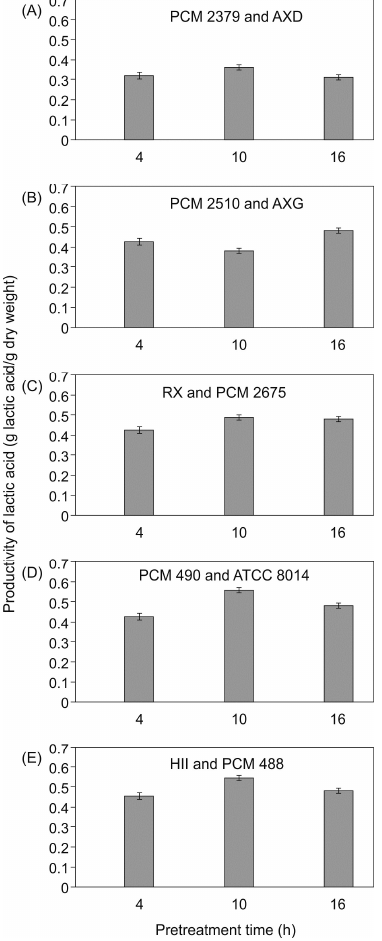
Figure 4. Productivity of lactic acid for ( A ) Lactococcuss lactis PCM 2379 and Lactobacillus plantarum AXD, ( B ) Lactobacillus acidophilus PCM 2510 and Lactobacillus plantarum AXG, ( C ) Lactobacillus plantarum R and Lactobacillus plantarum PCM 2675, ( D ) Lactobacillus delbrueckii PCM 490 and Lactobacillus plantarum ATCC 8014, and ( E ) Lactobacillus plantarum HII and Lactobacillus brevis PCM 480.